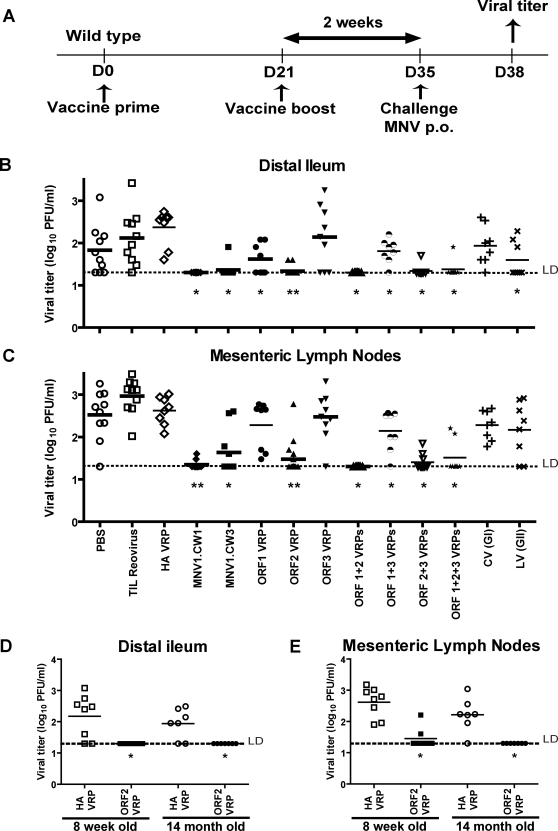
Short-term vaccination against MNV using live MNV strains and VRPs expressing ORF1, ORF2, and ORF3 from MNV and ORF2 from Chiba virus and Lordsdale virus.(A) Vaccination protocol used in short-term vaccination. Viral titers in (B) distal ileum and (C) MLN of adult (8-week-old) WT mice after MNV1.CW3 challenge following vaccination with the indicated vaccines. Viral titers in (D) distal ileum and (E) MLN of adult (8-week-old) or aged (14-month-old) WT mice immunized with MNV1.CW3 ORF2 VRP or HA VRP and challenged with MNV1.CW3. These data are pooled from two independent experiments with 3-5 mice per group in each experiment. (**) indicates p<0.0001, (*) indicates p<0.05. Unless otherwise stated, live virus vaccinations are compared to vaccination with reovirus, and VRP vaccinations are compared to HA VRP. LD indicates the limit of detection. Bars indicate the arithmetic mean.